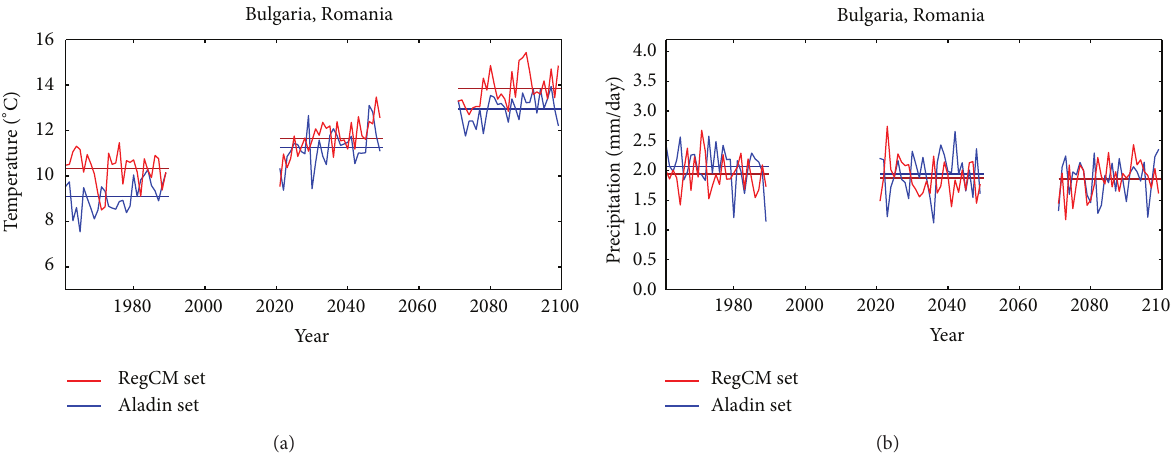
Figure 18: Average 2m temperature (a) and precipitation (b) over common area of Bulgaria and Romania; annual average (thin line) and 30-year average (thick